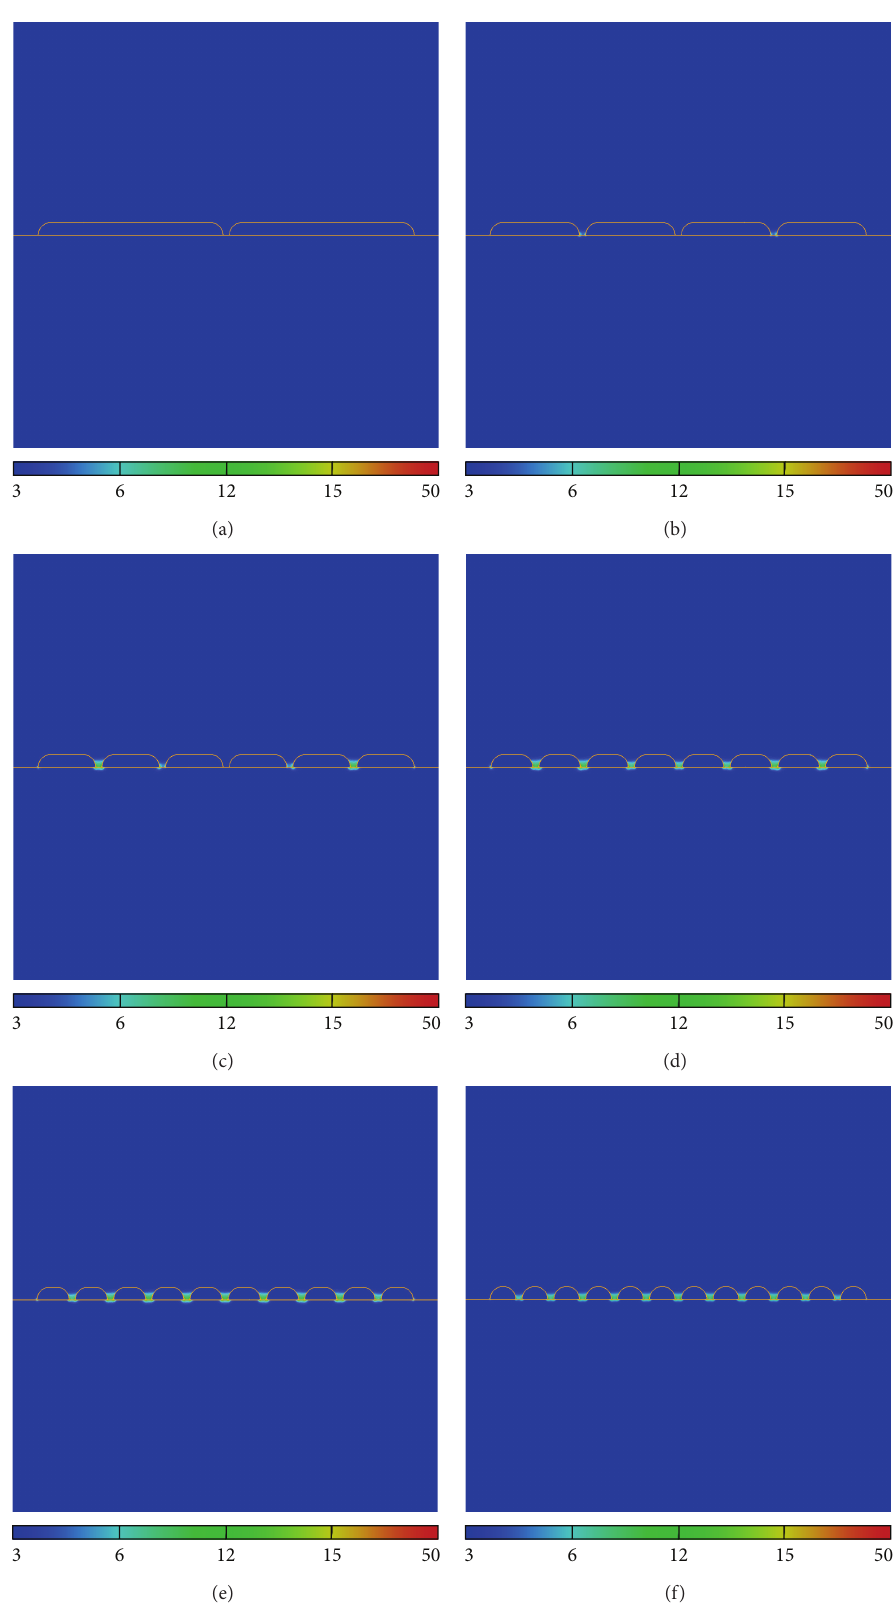
Figure 3: Spatial maps of the electric field amplitude for (a) 2, (b) 4, (c) 6, (d) 8, (e) 10, and (f) 12 gold nanostripes illuminated at 𝜆 = 632